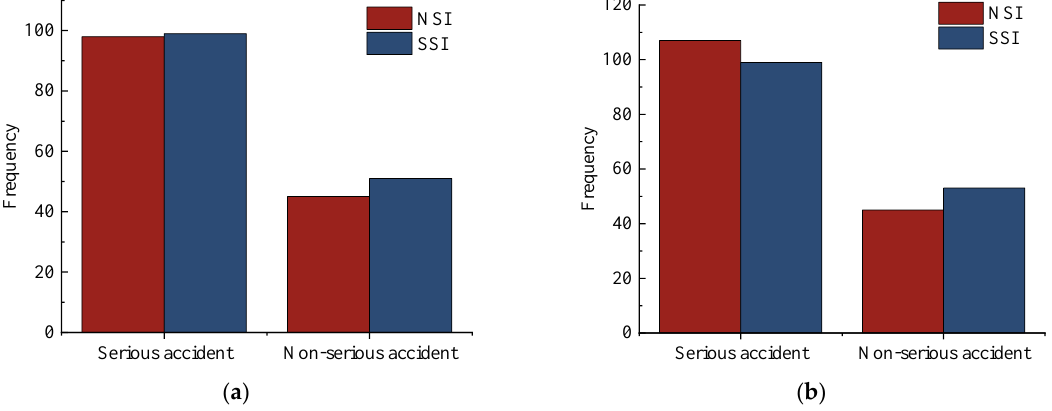
Figure 7. ( a ) Number of vehicles in Section Ⅰ ; ( b ) Number of vehicles in Section Ⅱ .